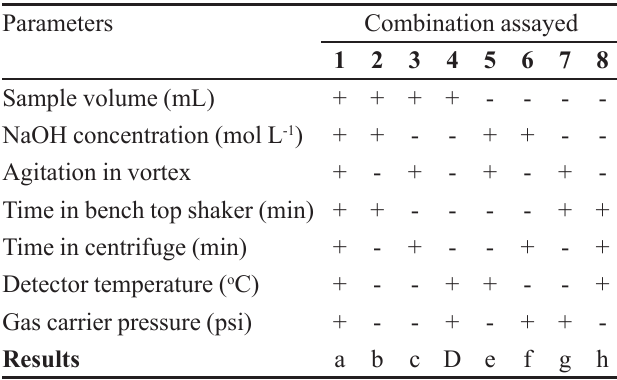
TABLE II - Combinations assayed for nominal or variable parameters